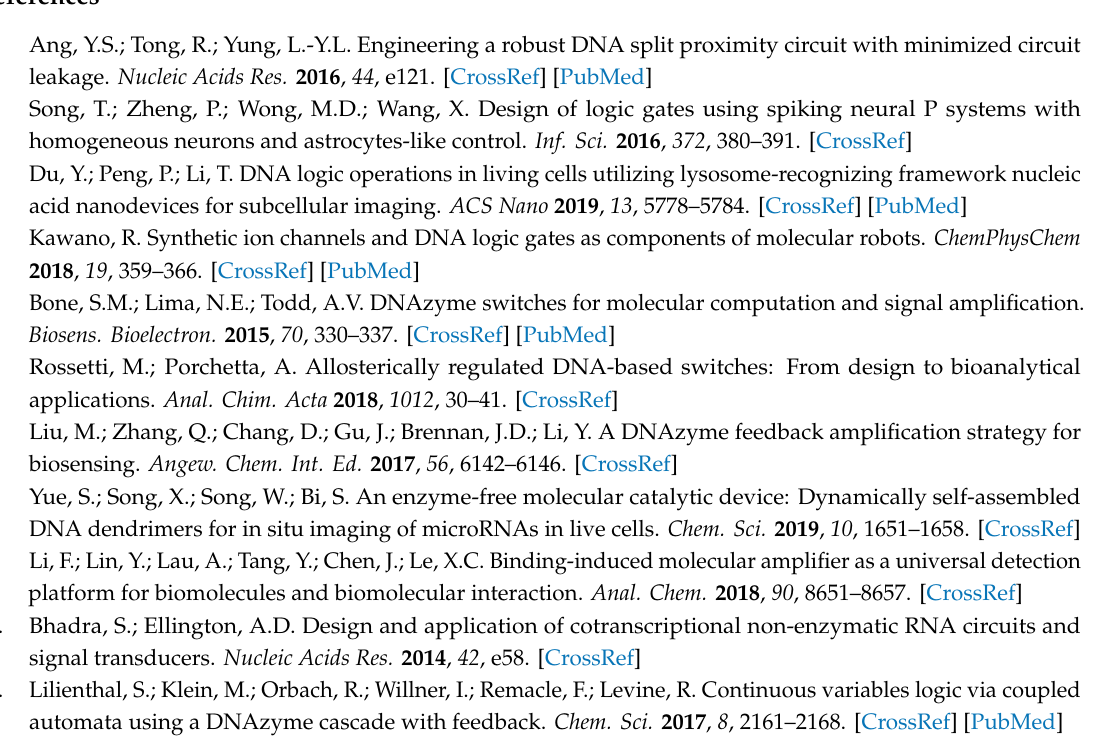
Supplementary Materials: The following are available online, Figure S1: The YES gate time-dependent normalized fluorescence intensity changes ( ∆ F / ∆ FMax) at di ff erent hairpin structure, Figure S2: The YES gate time-dependent normalized fluorescence intensity changes ( ∆ F / ∆ FMax) at di ff erent input concentrations, Figure S3: The AND gate time-dependent normalized fluorescence intensity changes ( ∆ F / ∆ FMax) at di ff erent input concentrations, Figure S4: (A) Schematic of the TAND logic gate, (B) TAND gate logic symbol and truth table, Figure S5: Gel analysis of the TAND gate reaction using 12% PAGE, Figure S6: (A) The TAND gate time-dependent normalized fluorescence intensity change ( ∆ F / ∆ FMax) at di ff erent inputs, (B) Comparison of time-dependent normalized fluorescence intensity changes ( ∆ F / ∆ FMax) between AND gate and TAND gate., Figure S7: (A) The INHIBIT gate time-dependent normalized fluorescence intensity change ( ∆ F / ∆ FMax) at di ff erent inputs, (B) Gel analysis of the INHIBIT gate reaction using 12% PAGE, Figure S8: (A) The YES-YES logic circuit time-dependent normalized fluorescence intensity change ( ∆ F / ∆ FMax) at di ff erent concentrations, (B) Statistical analysis of system concentrations, Figure S9: Gel analysis of the YES-YES reaction using 12% PAGE, Figure S10: Nupack simulation for sequences with hairpin structures in Table S1, Figure S11: Nupack simulations for single-stranded sequences in Table S1, Figure S12: Nupack simulations for double-stranded sequences in Table S1, Table S1: DNA